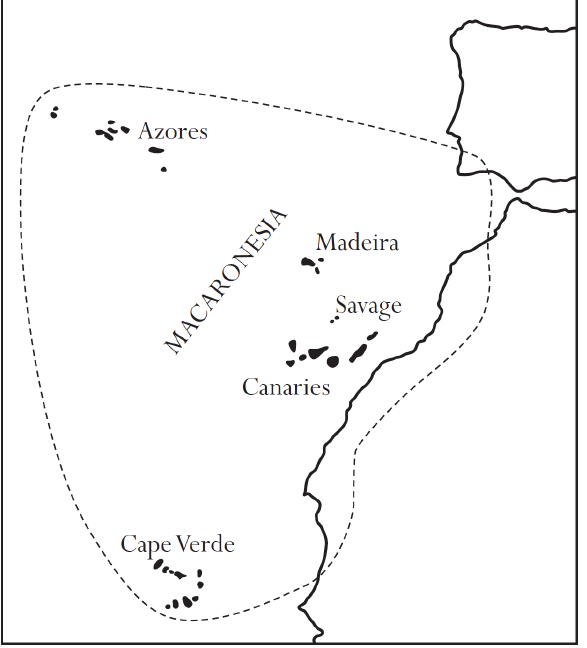
Figure 2. Macaronesia is a recognized but controversial biogeographical (in origin phytogeographical) region consisting of the archipelagos shown, together with a narrow coastal strip of north-west Africa and with affinities to the tip of the Iberian peninsula (after García-Talavera 1999).